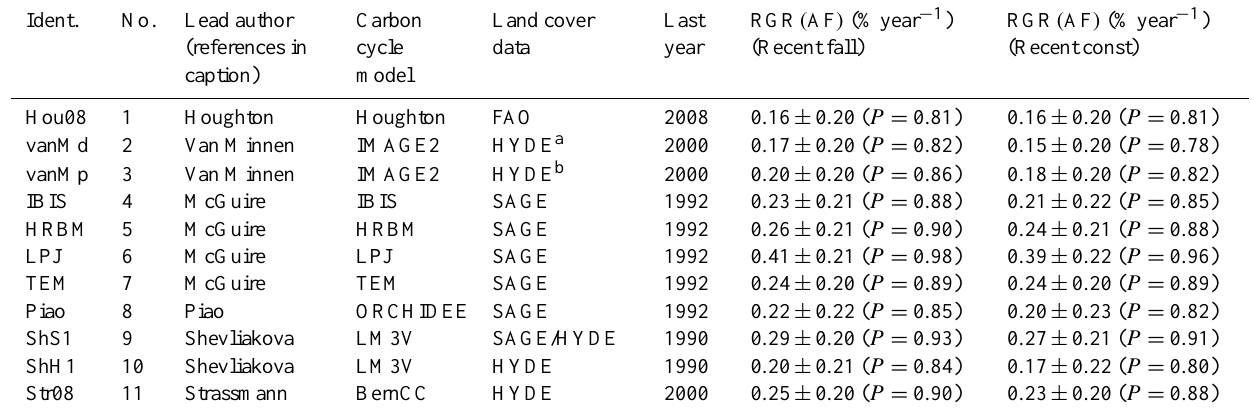
Table D1. Details of AF trend estimates from 11 alternative time series for CO 2 emissions from net land use change, f LUC . Trends are evaluated using Eq. (A2). Data are extrapolated from the last point in each series assuming either “Recent fall” (constant f LUC to 2000 and linear decline from 2000 to 2012 at 0.03PgCyear − 1 per year, with the constraint that f LUC not fall below the lesser of the last point and 0.5PgCyear − 1 ); or “Recent const” (constant f LUC to 2012). Time series are plotted in Fig. D3. The combined trend estimation method is used for all AF trend estimates. Ranges are ± 1 σ confidence intervals; P values in brackets give probability of positive trend. Ident.